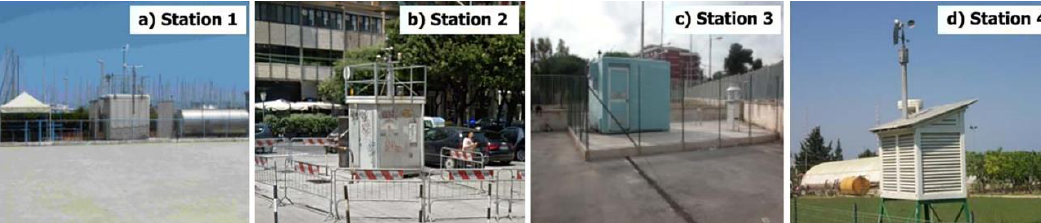
Figure 3. View from the ground of the four weather stations: ( a ) weather station 1 positioned near the University Sport Centre, ( b ) weather station 2 at corso Cavour, ( c ) weather station 3 at via Caldarola, ( d ) weather station 4 at the Mediterranean Agronomic Institute in Valenzano.